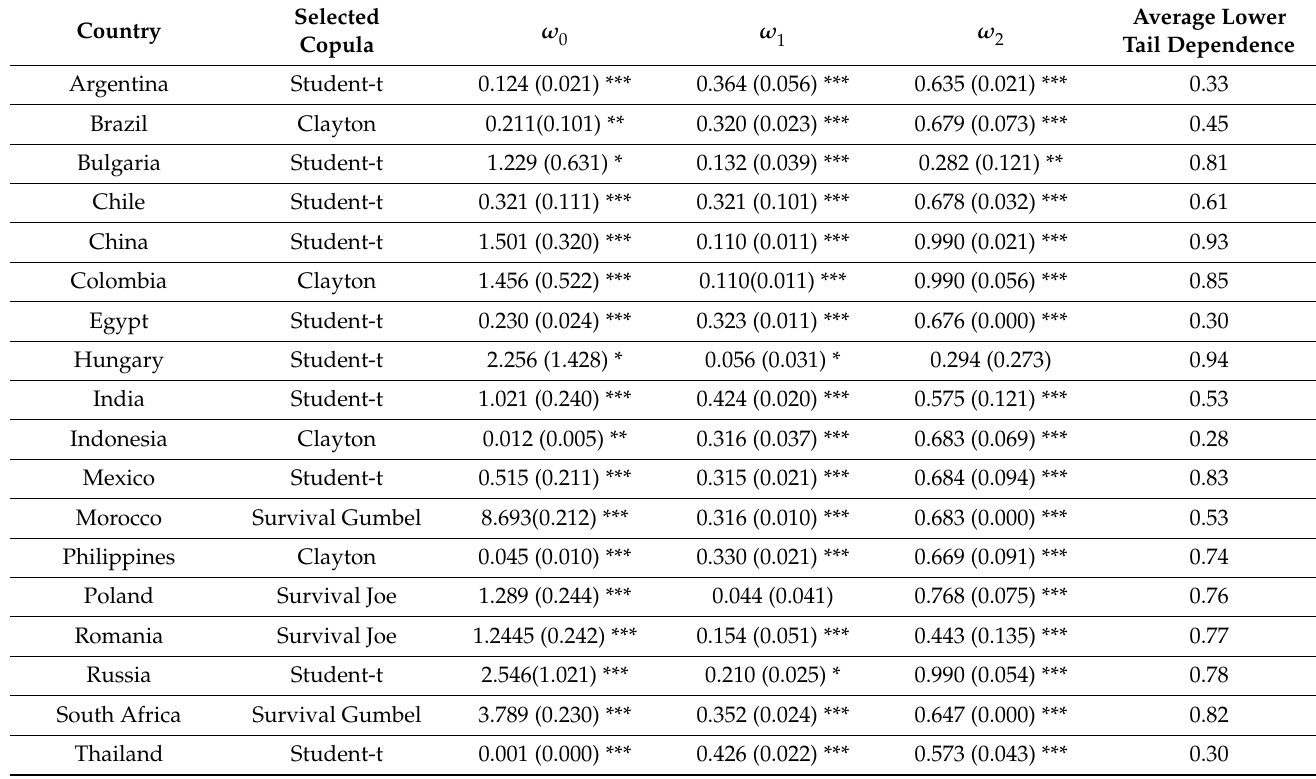
Average Lower Tail